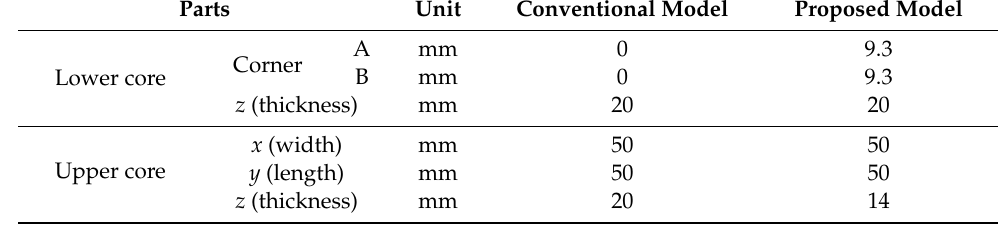
Table 3. Dimensional changes of the upper and lower cores in the proposed model.